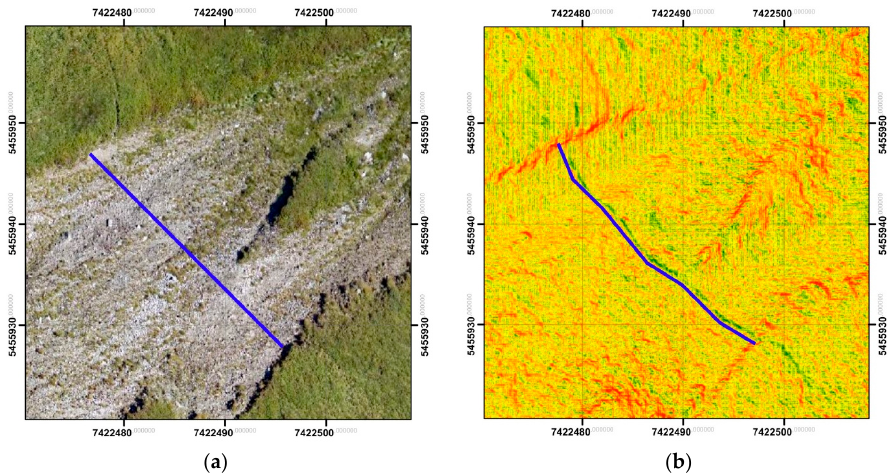
Figure 22. Rock debris: ( a ) orthoimage covering the invisible path; and ( b ) a map of slope allowing the detection of the trail (source: authors’ own study).